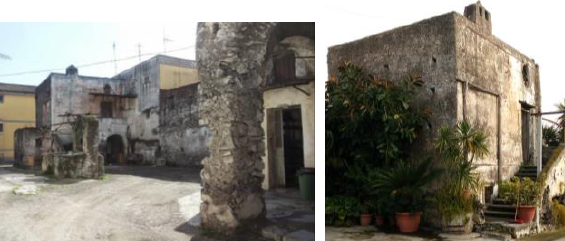
Figure 17 and 18. Village with well and A rural house (Boccia al Mauro,